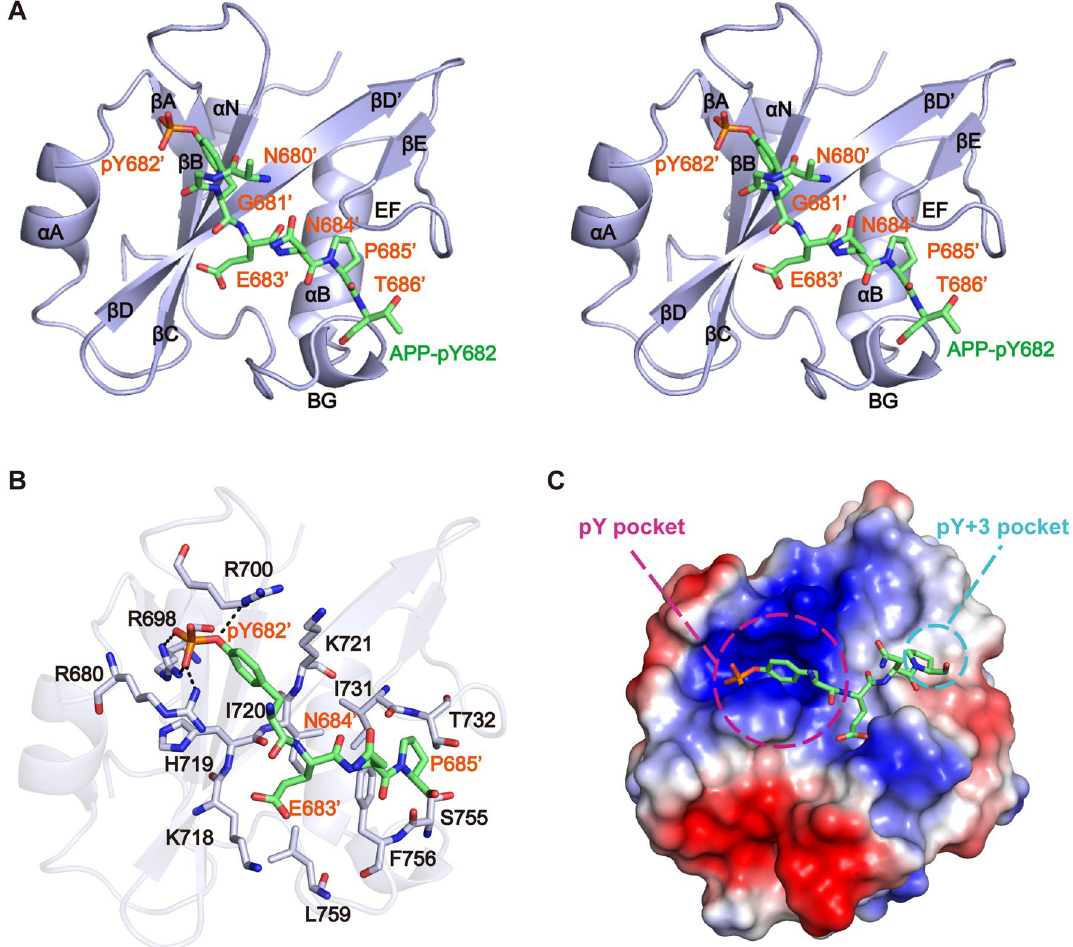
Figure 2. Specific interaction of the Vav2-SH2 domain and the peptide APP-pY682. ( A ) Overall stereoview of Vav2-SH2 domain in complex with peptide APP-pY682. Vav2-SH2 is colored purple, with the secondary structures are labeled. The APP-pY682 peptide (green) is shown in stick mode, with the residues N680 ′ , G681 ′ , pY682 ′ , E683 ′ , N684 ′ , P685 ′ and T686 ′ are labeled. ( B ) Detailed interactions of the peptide APP-pY682 with SH2 domain. The peptide APP-pY682 and the side chains of crucial residues are shown in stick mode and labeled respectively. Selected hydrogen bonds are colored in black. ( C ) Electrostatic potential surface representation of Vav2-SH2 domain bound to APP-pY682 peptide (green). The pY and pY + 3 pockets are indicated by magenta and blue circles